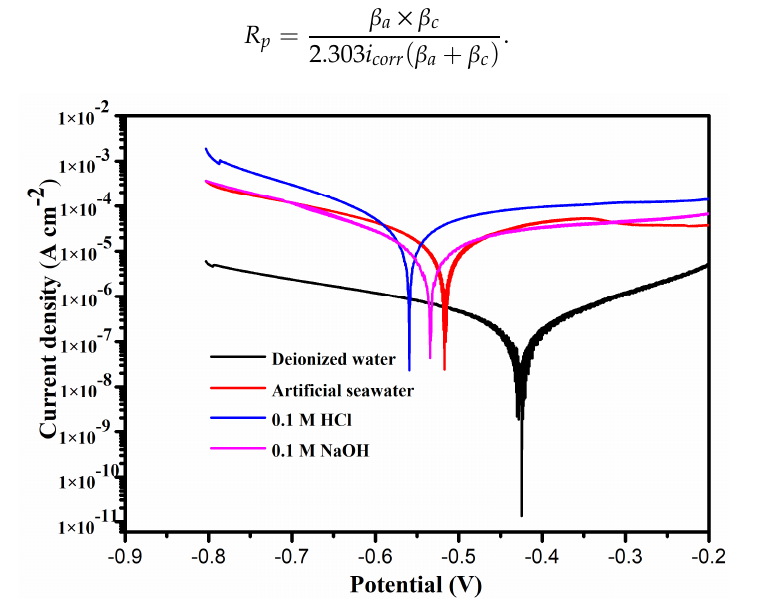
Figure 4. Potentiodynamic polarization curves of NiCrAlY coating sliding conditions in different corrosive solutions.